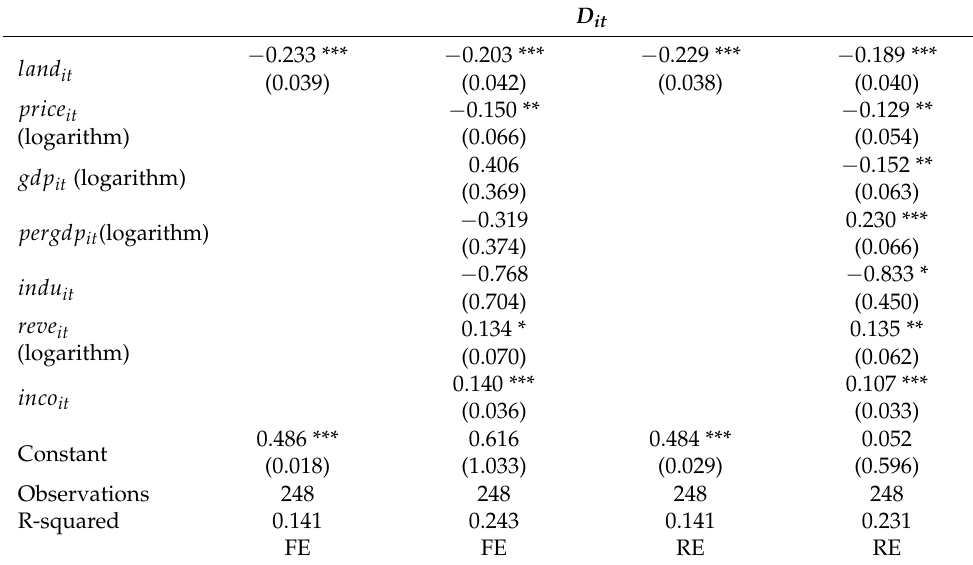
Table 2. Regression